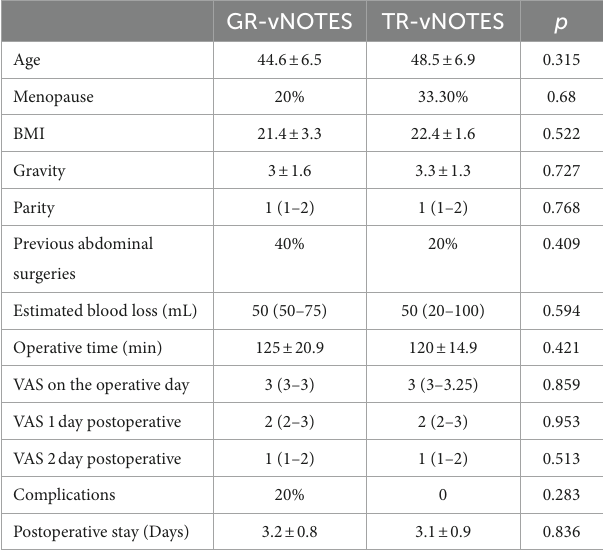
TABLE 1 The baseline data and operative outcomes in the GR-vNOTES and TR-vNOTES